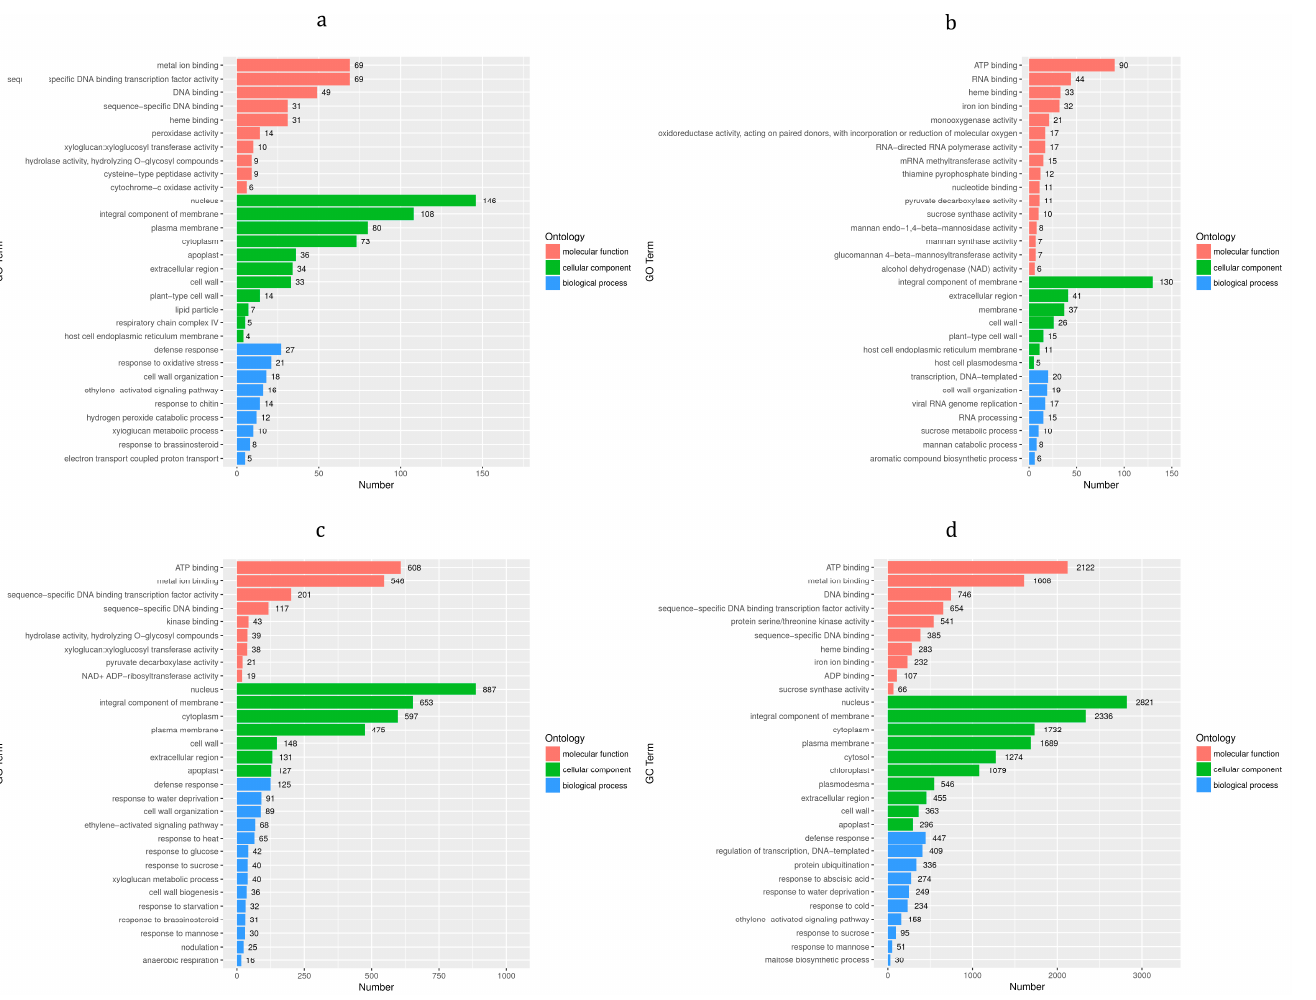
Figure 5. GO enrichment analysis of DEGs. Horizontal is number of DEGs and ordinate is GO term. Different colors were used to distinguish BP, CC and MF. ( a ) bx1 vs. ck1; ( b ) bx2 vs. ck2; ( c ) bx3 vs. ck3; ( d ) bx4 vs.